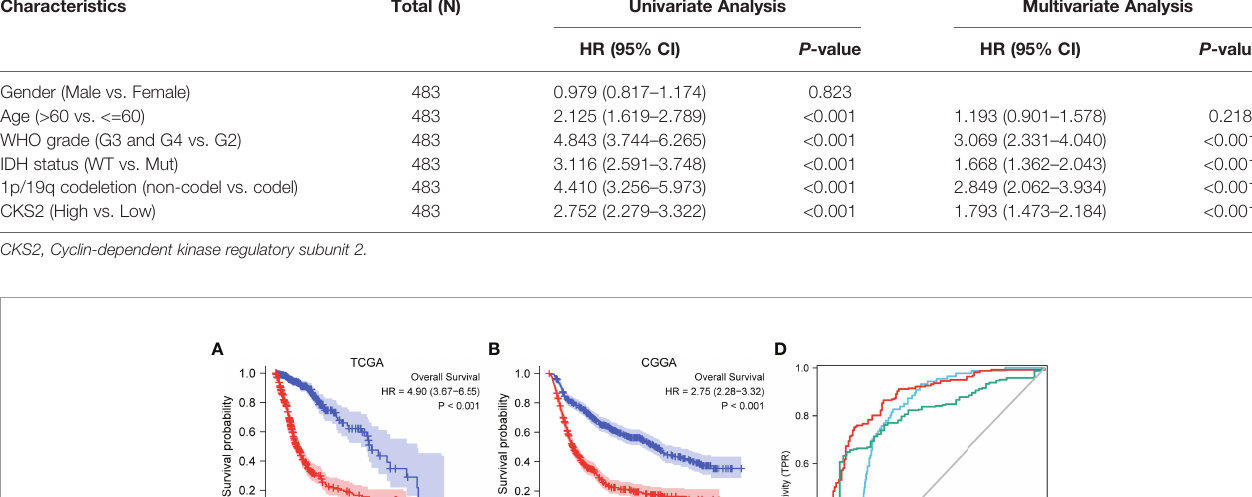
TABLE 2 | The univariate and multivariate analyses of overall survival according to CKS2 expression, after adjusting for other potential predictors in CGGA (n = 483). Characteristics